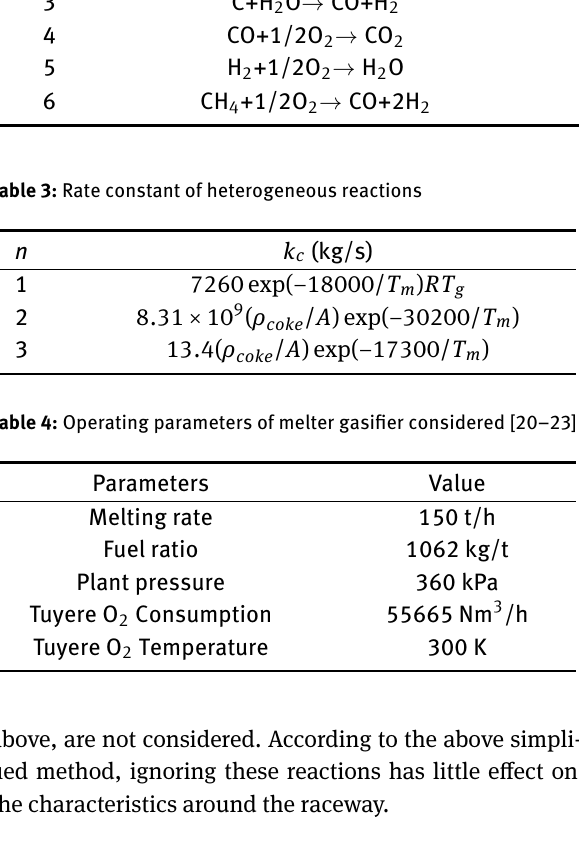
The diameter of tuyere is 0.03 m [20] The typical plant op- erating parameters of melter gasifier, as listed in Table 4, are used as the boundary conditions [20–23]. As for the wall, the free-slip condition is applied in the wall bound- ary for the gas phase. At any point along the wall, the en- ergy wall function is used to describe the wall heat loss. Be- sides, a zero-gradient condition for all species is assumed at walls